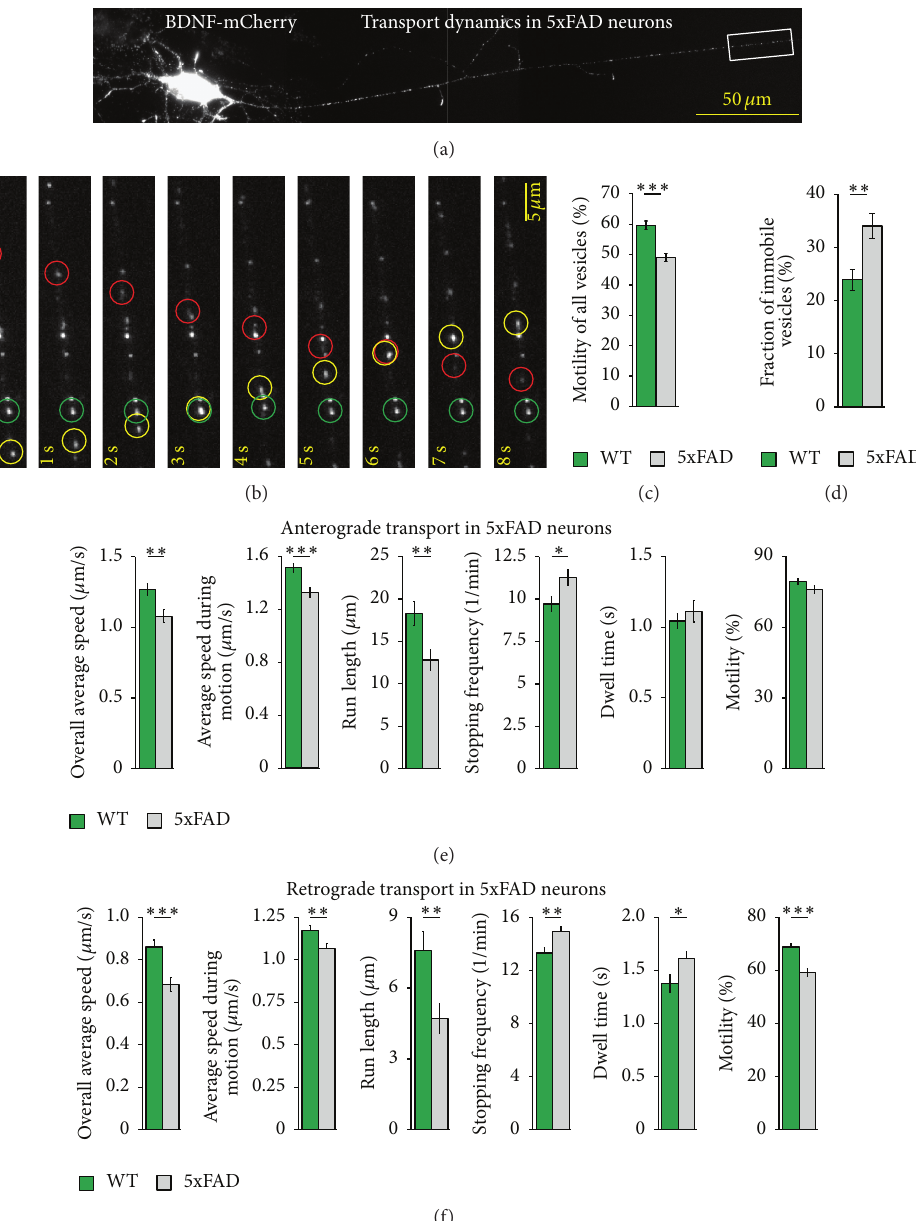
Figure 1: Transport dynamics of BDNF-containing vesicles in hippocampal neurons of 5xFAD mice. Dissociated hippocampal neurons of transgenic mice with five familial Alzheimer’s disease mutations (5xFAD) and wild-type littermates were transfected at 10DIV with fluorescently labeled BDNF. The dynamic behavior of BDNF-containing vesicles was analyzed by live cell imaging. (a) Representative picture of a hippocampal neuron transfected with BDNF-mCherry. (b) Boxed area from (a) at higher magnification and at different time points of time-lapse recording. Red and yellow circles mark BDNF-containing vesicles showing a directional movement. Red circle marks a vesicle whichmovesinanterogradedirectionfromthesomatodistalpartoftheneurite,whileyellowcirclemarksavesiclewhichmovesinretrograde directionfromdistalpartoftheneuritetothesomaoftheneuron.Greencirclemarksavesiclewhichwasimmobileduringobservation.(c)Bar diagram showing the mean motility of BDNF-containing vesicles in hippocampal neurons of 5xFAD mice compared to wild-type littermates. Note that the motility of BDNF-containing vesicles was significantly reduced in hippocampal neurons from 5xFAD mice compared to wild- type littermates. (d) Bar diagram indicates the percentage of immobile BDNF-containing vesicles. Note that there are significantly more immobile vesicles in neurons of transgenic animals compared to wild-type littermates. (e) Transport characteristics of mobile anterogradely directed BDNF-containing vesicles. Bar diagrams show motional properties of BDNF-containing vesicles as indicated. The overall average speed and the average speed during motion, run length, and stopping frequency of BDNF-containing vesicles were significantly changed in neurons of transgenic animals compared to wild-type littermates. (f) Motional properties of retrogradely directed BDNF-containing vesicles. All motional properties of BDNF-containing vesicles moving in retrograde direction were significantly changed in neurons of transgenic animals compared to wild-type littermates. ( ∗ 𝑝 < 0.05 , ∗∗ 𝑝 < 0.01 , ∗∗∗ 𝑝 < 0.001 ; one-way ANOVA). Error bars represent